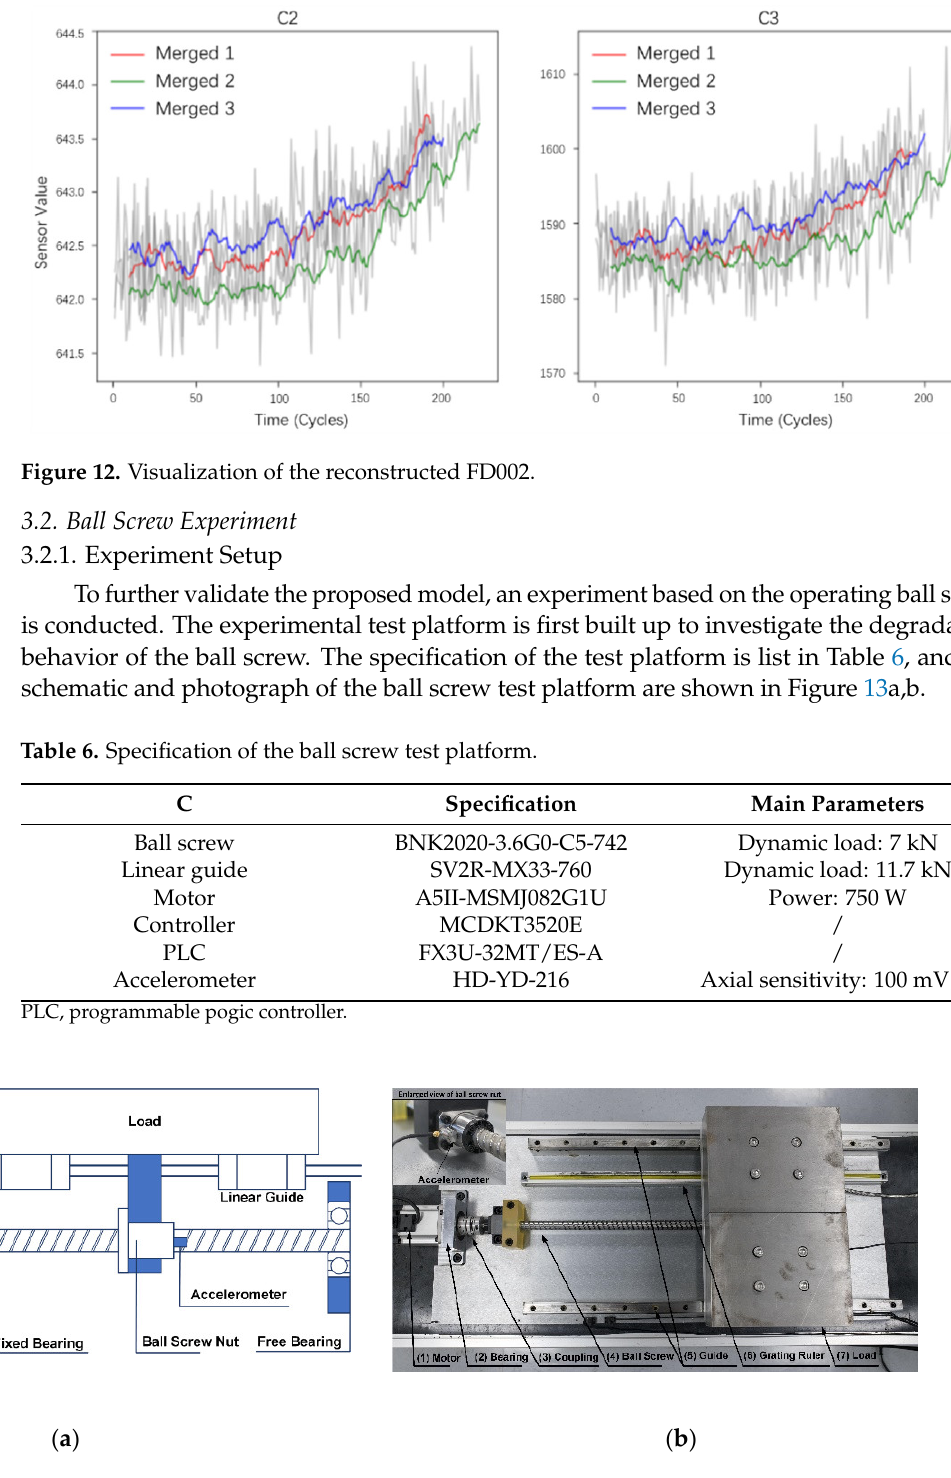
Figure 12. Visualization of the reconstructed FD002.